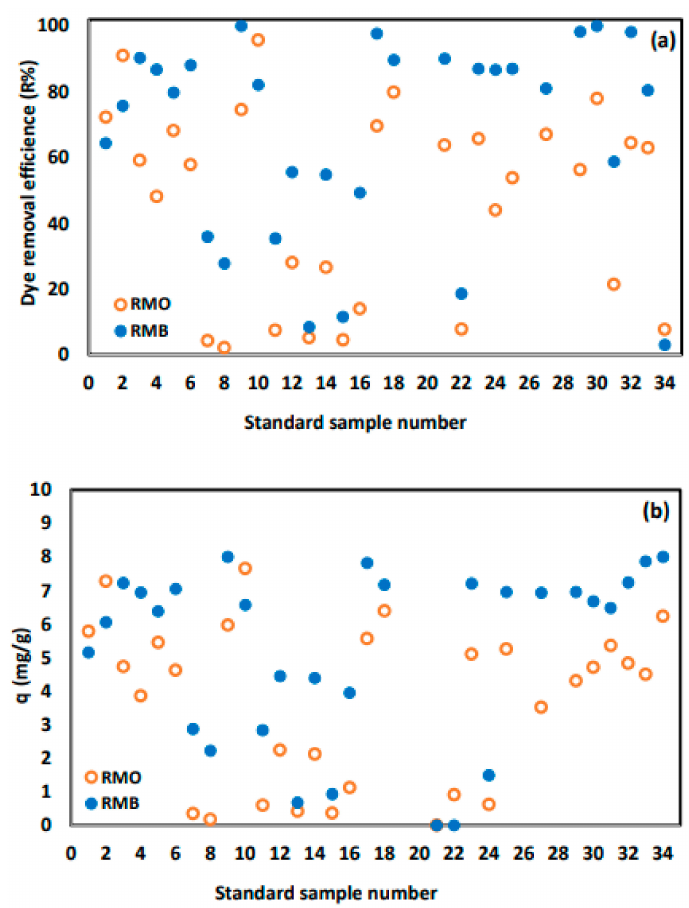
Figure 6. ( a ) Removal e ffi ciencies (R) and ( b ) adsorption capacities (q) of MO and MB by adsorption on the 34 prepared ZnO samples.